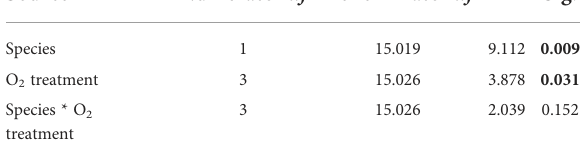
TABLE 1 Summary of results for LMMs comparing dark respiration rates between treatments for both Porites sp. and G. fascicularis . Source F Sig.